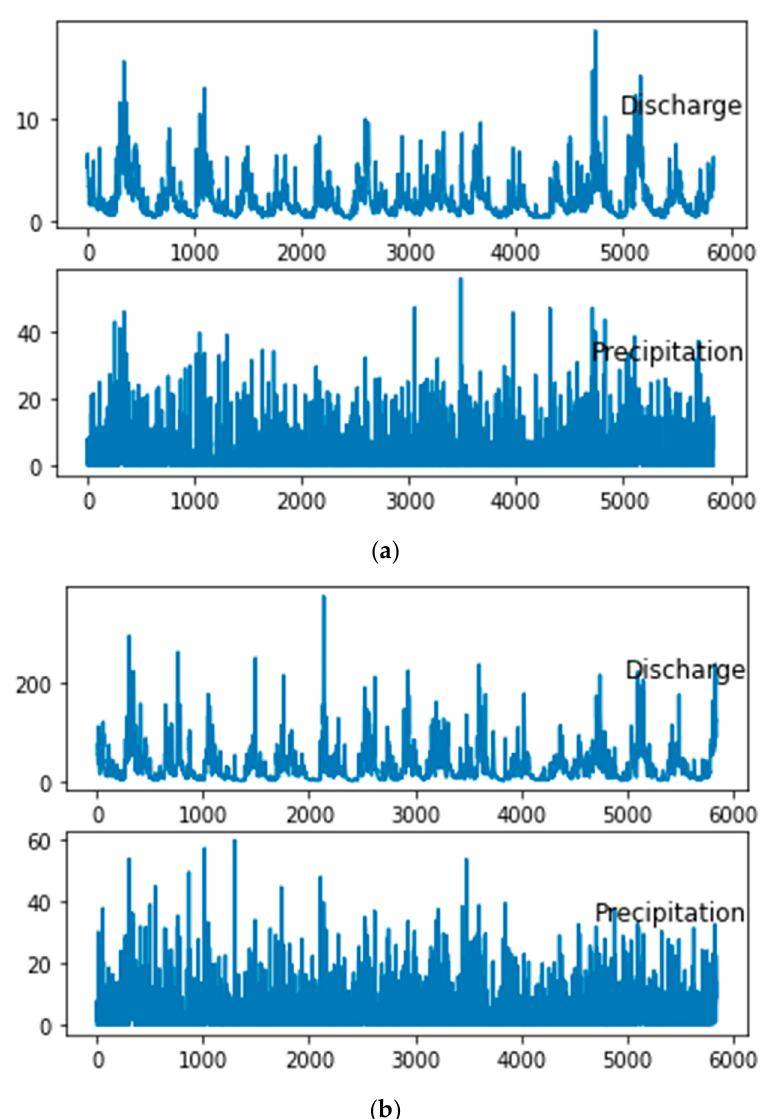
Figure 3. Daily discharge and rainfall of ( a ) the small basin (Fal at Tregony), ( b ) the large basin (Teifi at Glanteifi).